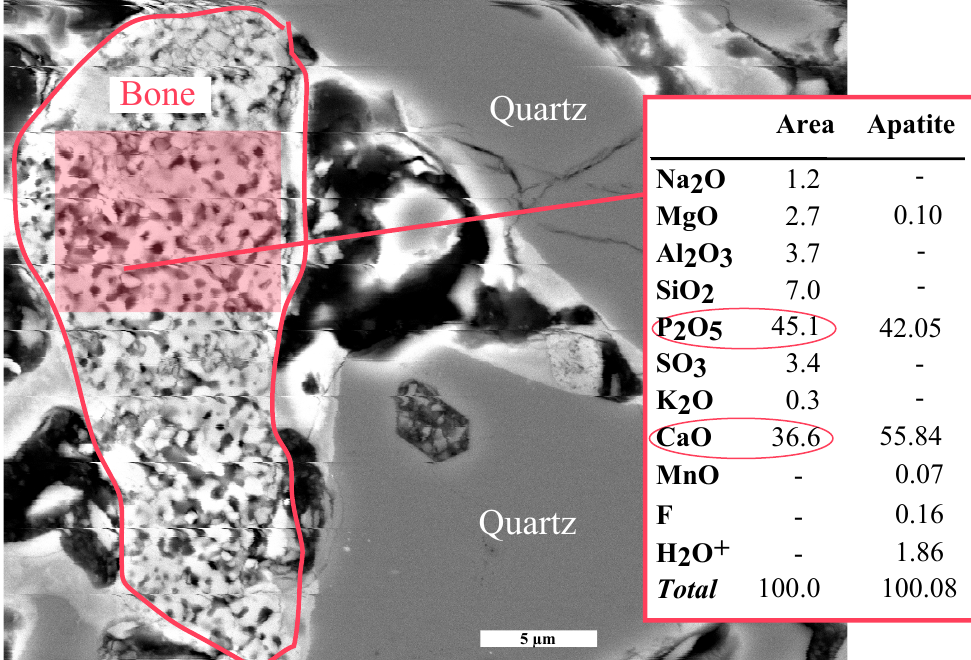
Figure 15. SEM-BSE image of a bone fragment with the typical microtexture and comparison of its composition (red area, wt %) with that of an apatite. Kilchberg-Schooren, sample SH 22. Slightly modified from [64]. © Kantonsarchäologie